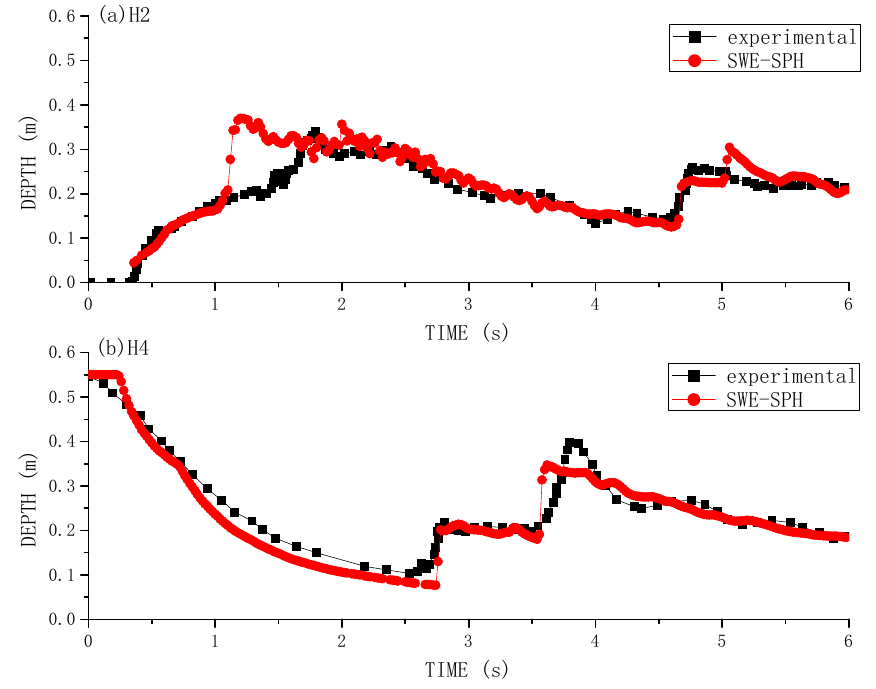
Figure 5. Time histories of dam break flow surface profile at gauging points between experimental data [21] and SWE-SPHysics modeling results at: ( a ) H2; and ( b ) H4. Different from the previous triangular hump which occupies the whole cross-sectional area forming a 2D problem, the present rectangular obstacle occupies only a fraction of the cross section and thus the flow pattern is highly 3-dimensional with complex flood wave diffractions and superimpositions. As shown in Figure 6a,b for the velocity field of dam break flow at two different time instants, parts of the flow overtop the obstacle crest with reflection, while most of them propagate towards the downstream region around both sides of the obstacle, as shown at time t = 0.74 s in Figure 6a. Furthermore, when the two water streams arrive at the downstream boundary, they tend to converge along the middle section of the wall and then collide to form two symmetric circulation vortices, as shown in Figure 6b at time t = 1.76 s. The vortices could stay there for a while until being diminished by the second reflection wave from the upstream reservoir area.